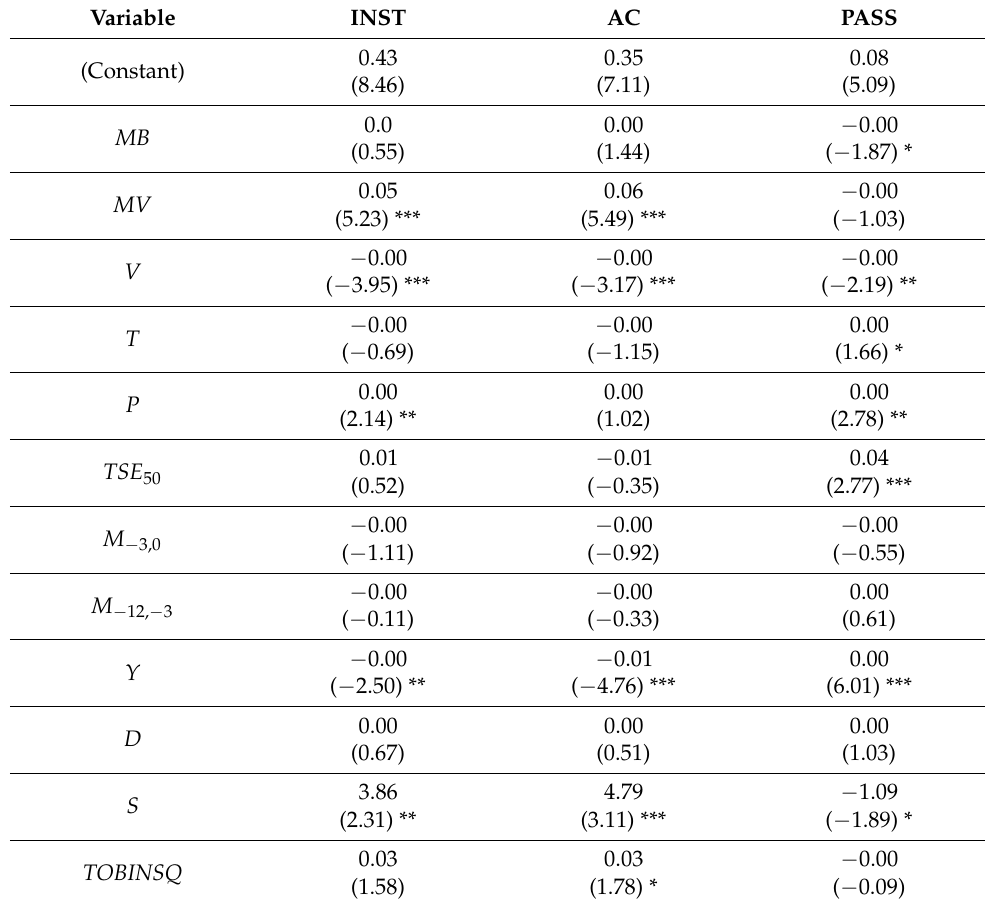
Table 2. Endogeneity results (Equation